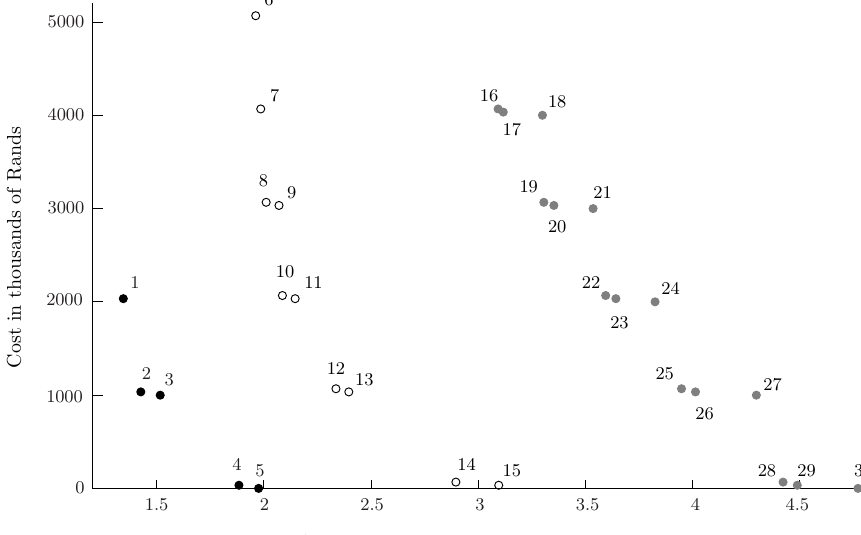
(solutions 1–5), t (solutions 6–15) and t 20 39 §